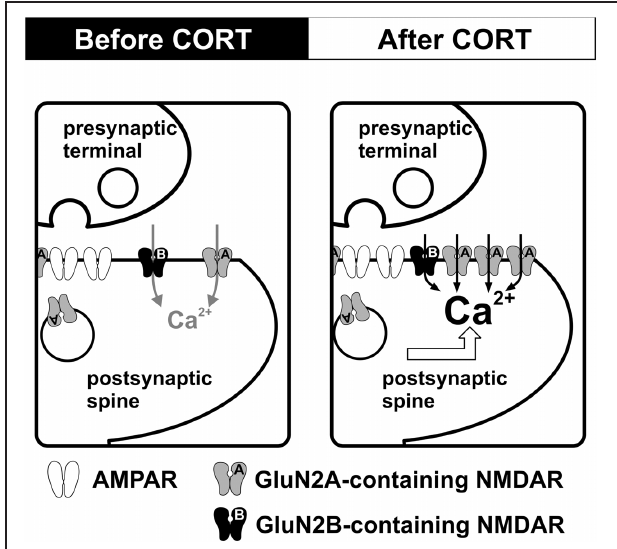
FIGURE 1 | CORT-induced dynamic regulation of synaptic NMDARs in the adult hippocampus. Schematic diagrams summarize the impact of CORT on NMDAR function. Compared with controls ( left ), stress level CORT treatment (100nM, 30min) induces a fast-onset increase in synaptic NMDAR function and a slow-onset (1–2h after CORT treatment) enhancement of the surface expression of GluN2A-containing NMDAR ( right